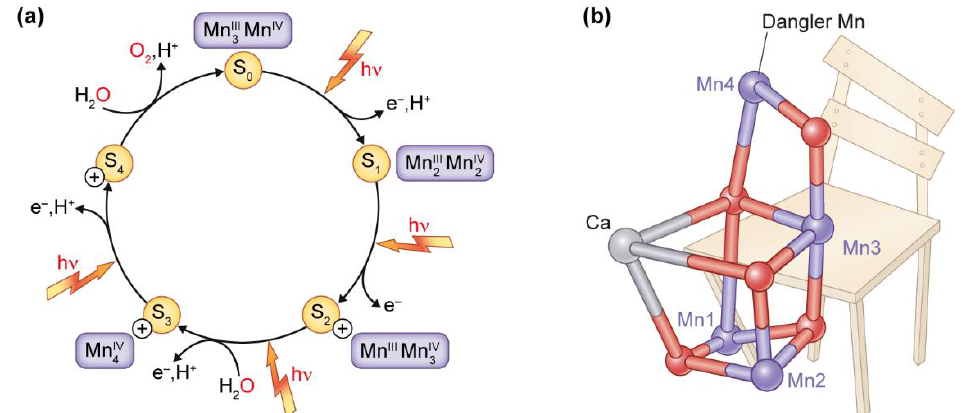
Figure 3. ( a ) The Kok cycle showing the steps of oxygen evolution in the oxygen evolving complex (OEC) of photosystem II (PSII) with details of the S i states (S 0 – S 4 ), the light induced oxidation steps of electron (e − ) and proton (H + ) release, together with the uptake of two molecules of H 2 O, which can be summarized to: 2H 2 O → 4H + + 4 e − + O 2 . ( b ) The chemical structure shows the configuration and position of the metal atoms in the Mn 4 Ca cluster, resembling a distorted chair-like form. The distorted seat base is formed by three Mn and one Ca atoms in a cubane structure, and the back is formed by the fourth Mn (Mn4), the so-called dangler Mn, which lies outside the cubane, and has been proposed to act as the site of catalysis.